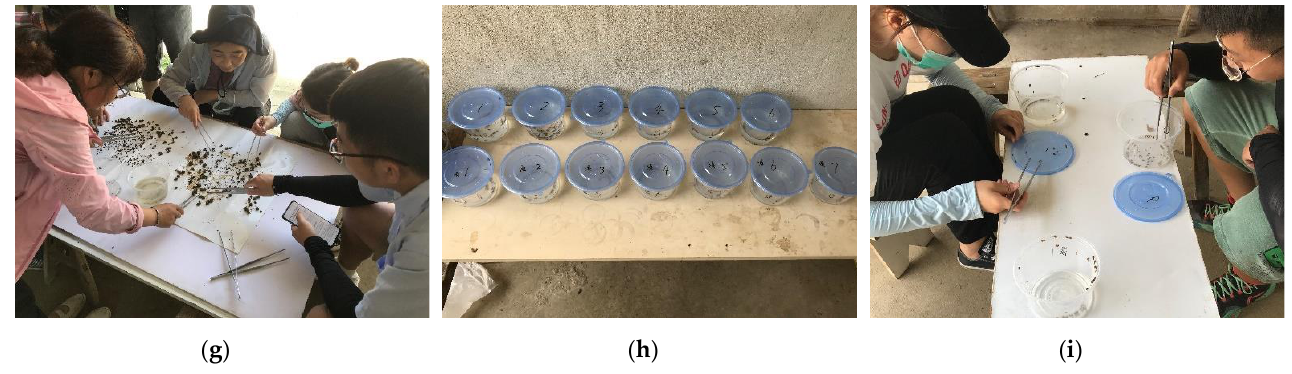
Figure 1. In the ditch experiments, seven rectangle-shaped ditches were prepared for the experiments ( a ). We measured the PBQ and put it into the study ditches ( c ). At 3 days after molluscicide application, snails in each ditch were collected and the mortality of the snails was evaluated via the warm water method combined with the percussion method ( h , i ). In the field tests, we first prepared fields for study ( b ). We measured the PBQ ( c ), stirred well ( d ), and sprayed it into the study fields ( e ). Before and after spraying molluscicide, snails were investigated ( f , g ) and identified as dead or alive ( h , i ). The snail mortality showed clear dose-dependent effects ( χ 2 = 18.353, p = 0.003) at 1 day following PBQ treatment. The mortality rates were 70.46, 80.31, 90.53, and 97.54% following PBQ treatment at doses of 0.25, 0.5, 1, and 2 g/m 3 , respectively (Table 1). The highest mortality of O. hupensis was at 2 days after PBQ treatment. At the dose of 1 g/m 3 PBQ, the mortality rate of O. hupensis was comparable with the mortality rate at the dose of 4.00 g/m 3 MNSC after exposure for 1 and 2 days ( χ 2 = 0.827, p = 0.363; χ 2 = 0.918, p = 0.338). After 3 days, the mortality rates of O. hupensis were comparable between 2 g/m 3 PBQ and 4.00 g/m 3 MNSC ( χ 2 = 1.207, p = 0.272). At doses equal to or greater than 0.5 g/m 3 , PBQ treatment produced O. hupensis snail mortality over 90% at 3 days. Compared with previous tests, PBQ (20% SC) exhibited higher molluscicidal activity Table 1. Molluscicidal effect of PBQ (20% SC) in ditch experiments.